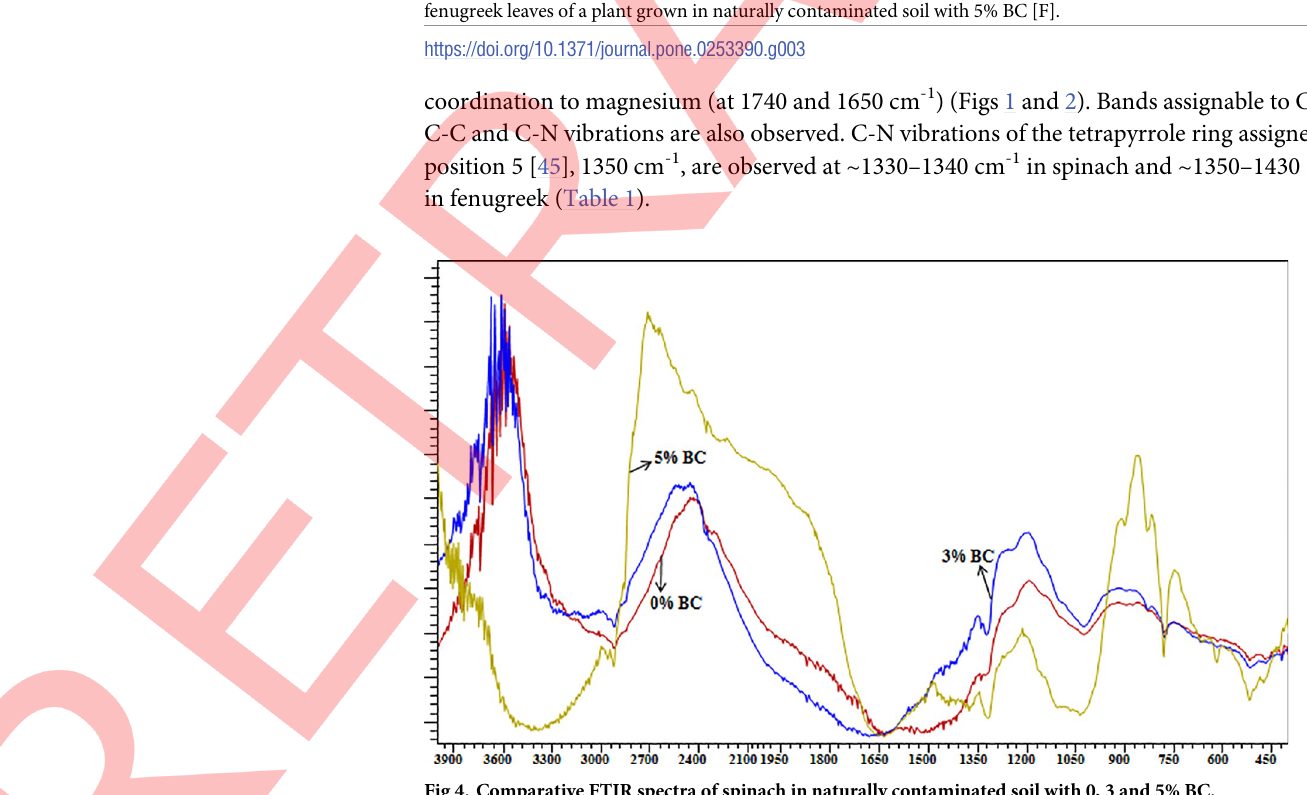
Fig 4. Comparative FTIR spectra of spinach in naturally contaminated soil with 0, 3 and 5%